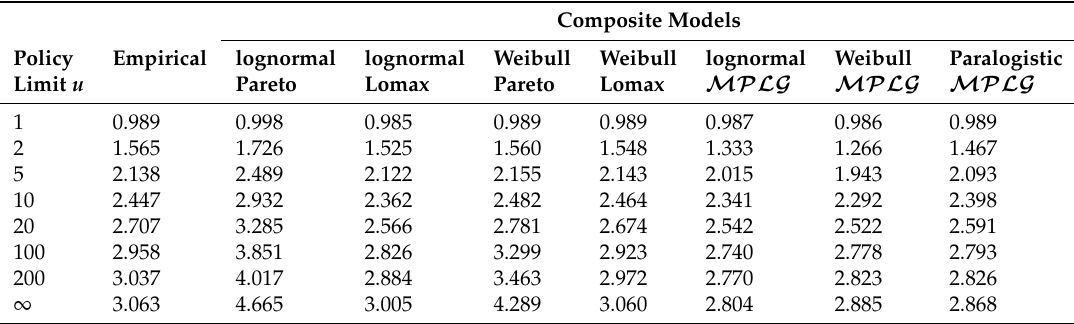
Table 3. Limited expected value for the distributions considered and different values of the policy limit u